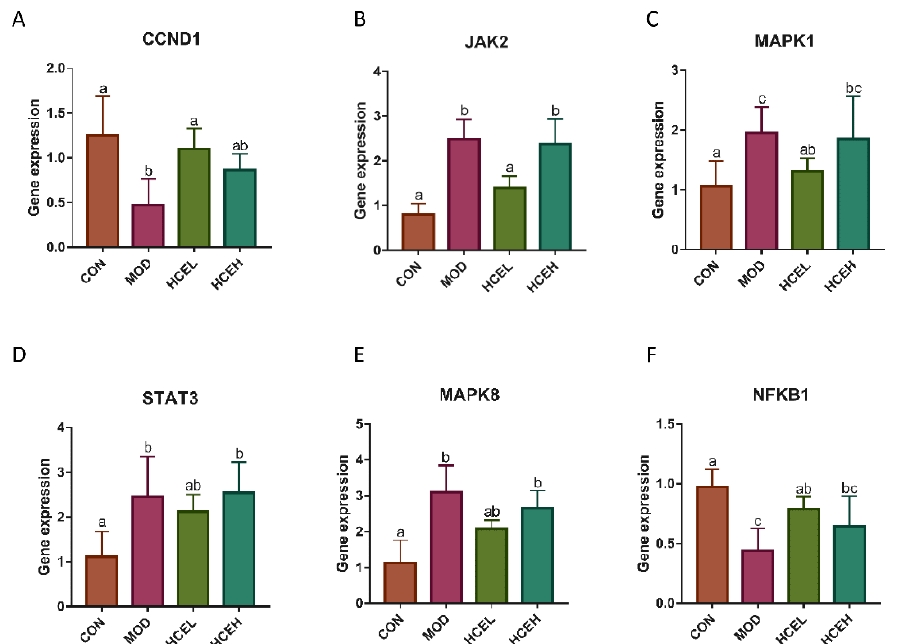
Figure 6. The effects of HCE on gene expression of prolactin signalling pathway in mammary gland of dams. The expression of CCND1 ( A ), JAK2 ( B ), MAPK1 ( C ), STAT3 ( D ), MAPK8 ( E ), and NFKB1 ( F ). For all images, different letters indicate a significant difference between columns, p < 0.05. CON: the control group ( n = 5); MOD: the chronic unpredictable mild stress group ( n = 5); HCEL: the HCE low dose group ( n =5); HCEH: the HCE high dose group ( n = 5).